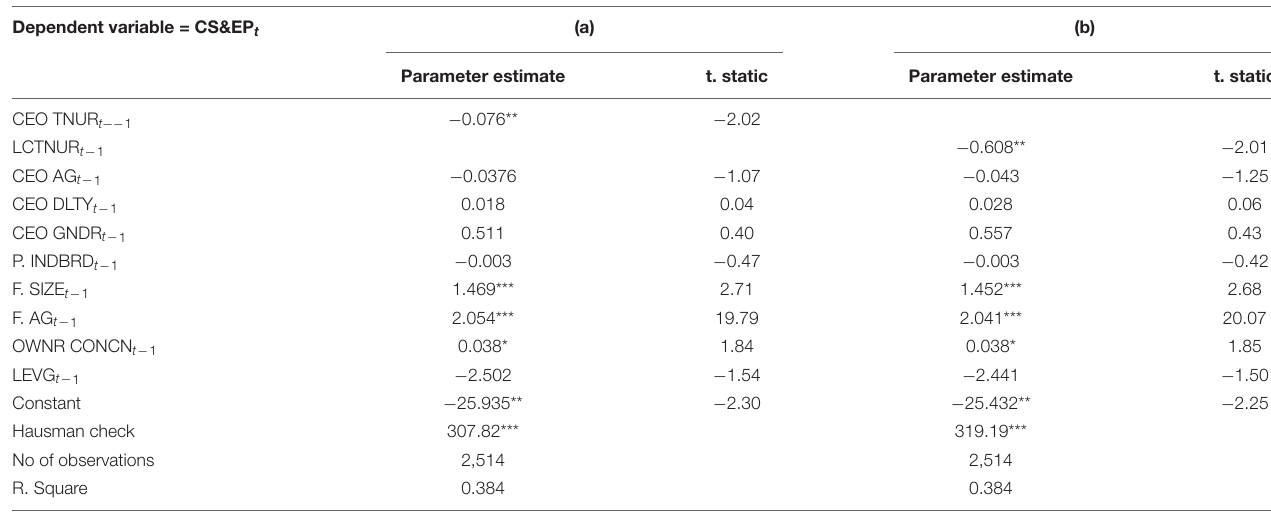
TABLE 4 | The effect of tenure on